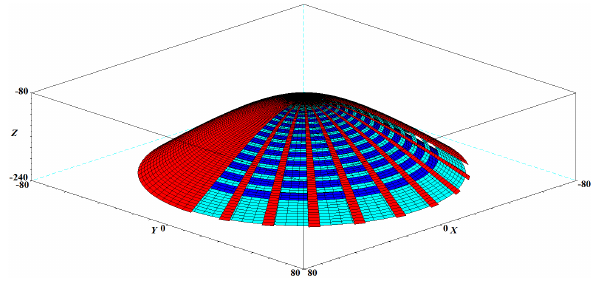
Figure 4: Fragment of the (red) two-sheet hyperboloid S h ( t , v ) , the (bright blue) two-sheet hyperboloid S h 1 ( ϕ , v ) and the (blue) hyperboloid offset surface off( S h ; d )